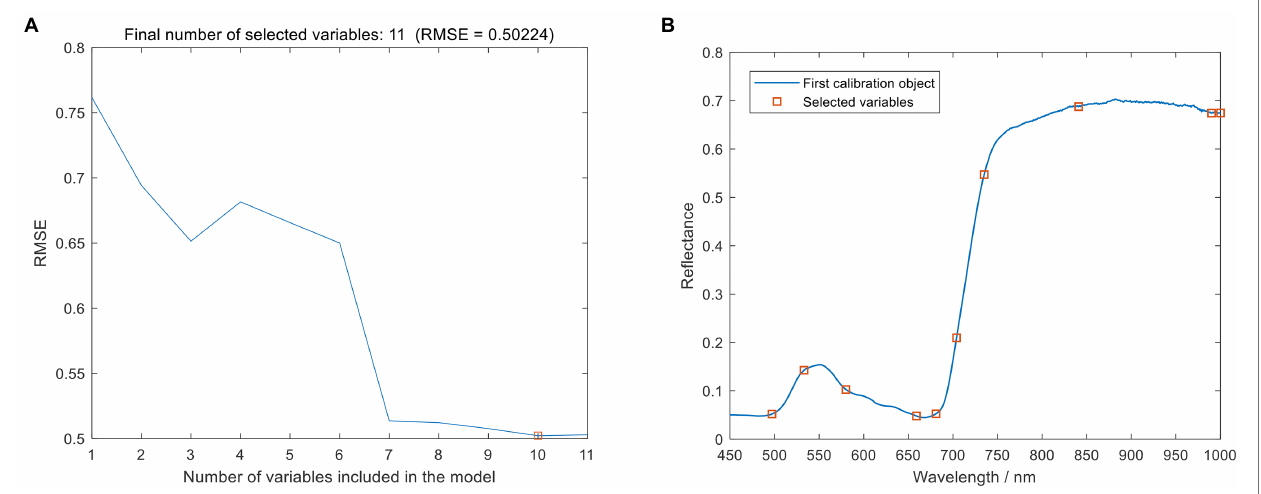
FIGURE 6 | Selected o spectral characteristics wavelength using sequential projection algorithm (SPA). (A) Number of optimal spectral variables. (B) Characteristic wavelengths for